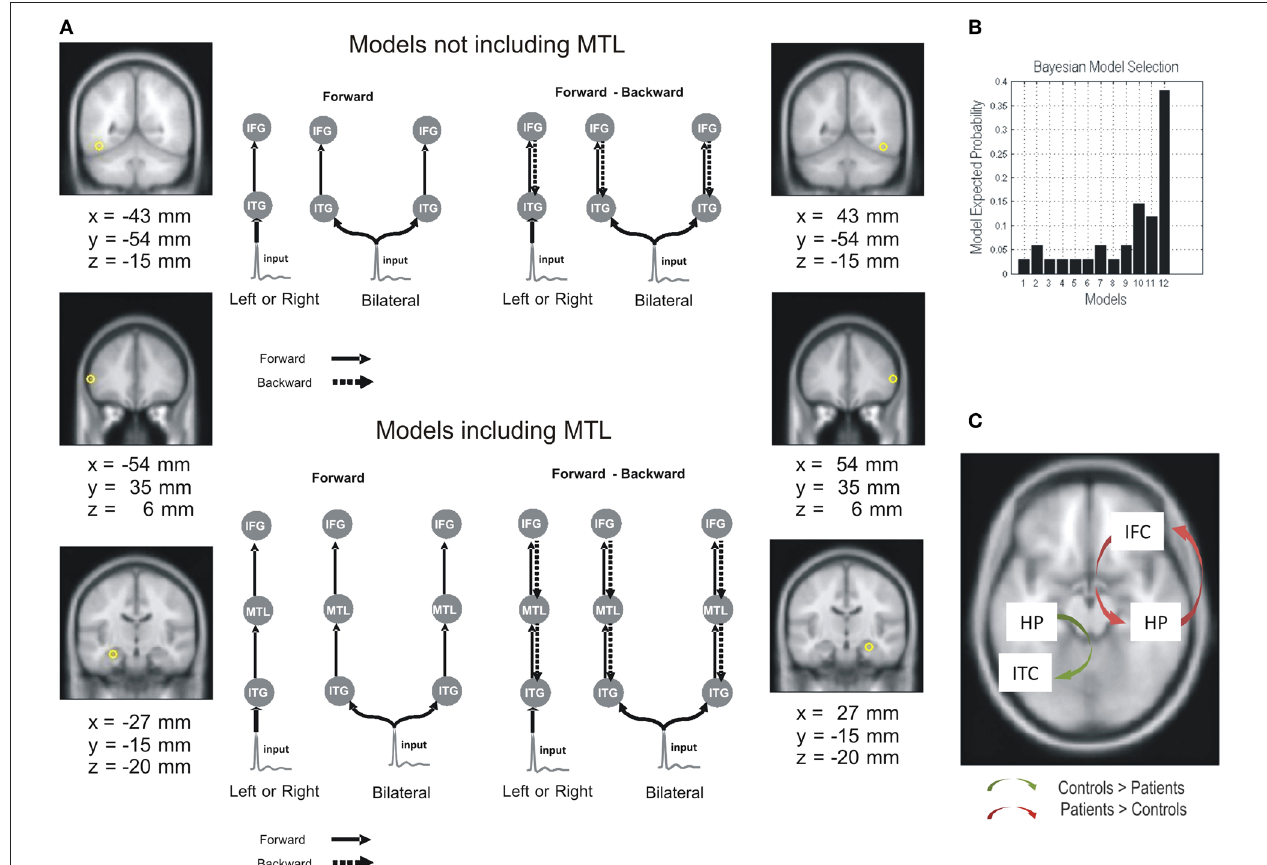
FIGURE 2 | Effective connectivity differences between mTLE patients and controls in a verbal WM task. Dynamic causal models, extracted from magnetoencephalographic recordings during verbal WM encoding, were compared in TLE patients (with left hippocampal sclerosis) and controls. (A) Network architecture was specified on the basis of the inverse solutions for single subjects using multiple sparse priors. Twelve models were specified and inverted separately for each subject. Outlines of some of DCM models for the effective connectivity analysis are depicted. The models were constructed starting with simple architectures and adding hierarchical levels (i.e., sources and extrinsic connections). The simplest models only included